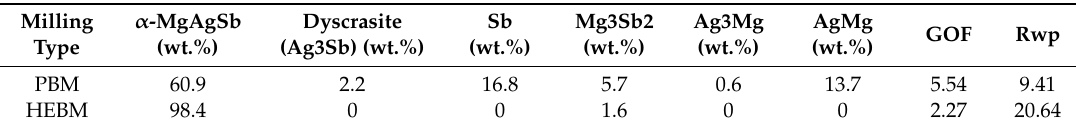
Table 1. Phase proportions in the samples obtained by Rietveld refinement for di ff erent ball-milling